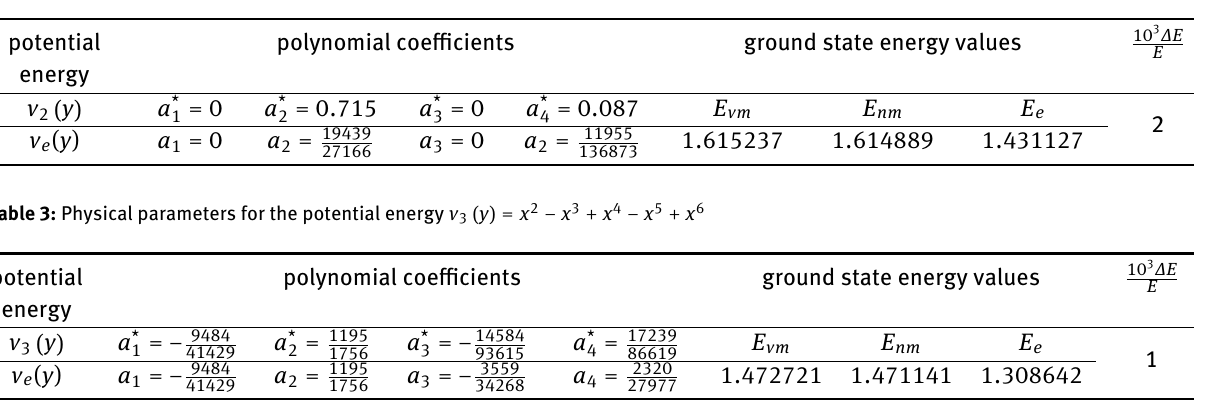
Table 2: Physical parameters for the potential energy v 2 ( y ) = y 2 + y 4 + y 6